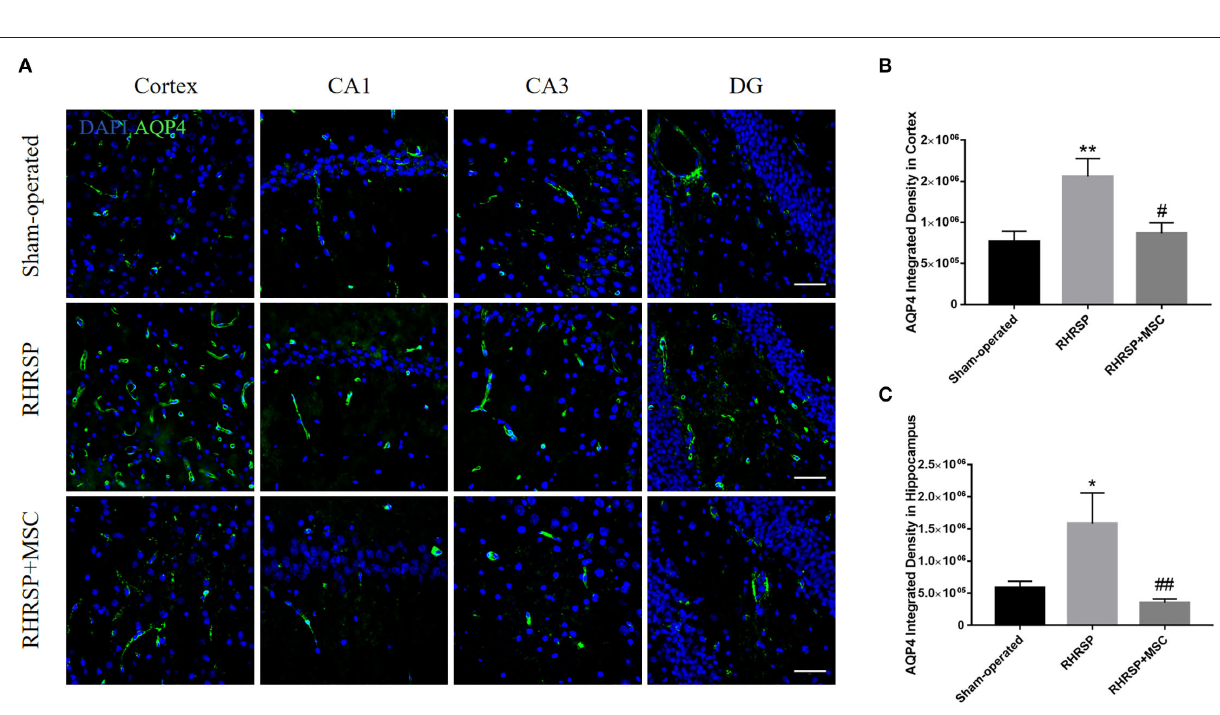
FIGURE 5 | Effects of MSCs on AQP4 expression. (A) Immunofluorescent staining of AQP4 in the cortex and hippocampus. (B,C) Quantification of the fluorescence intensity of AQP4 in the cortex and hippocampus (* P < 0.05, ** P < 0.01, vs. sham-operated group; # P < 0.05, ##P < 0.01, vs. RHRSP group; n = 6/group). scale bar = 50 µ